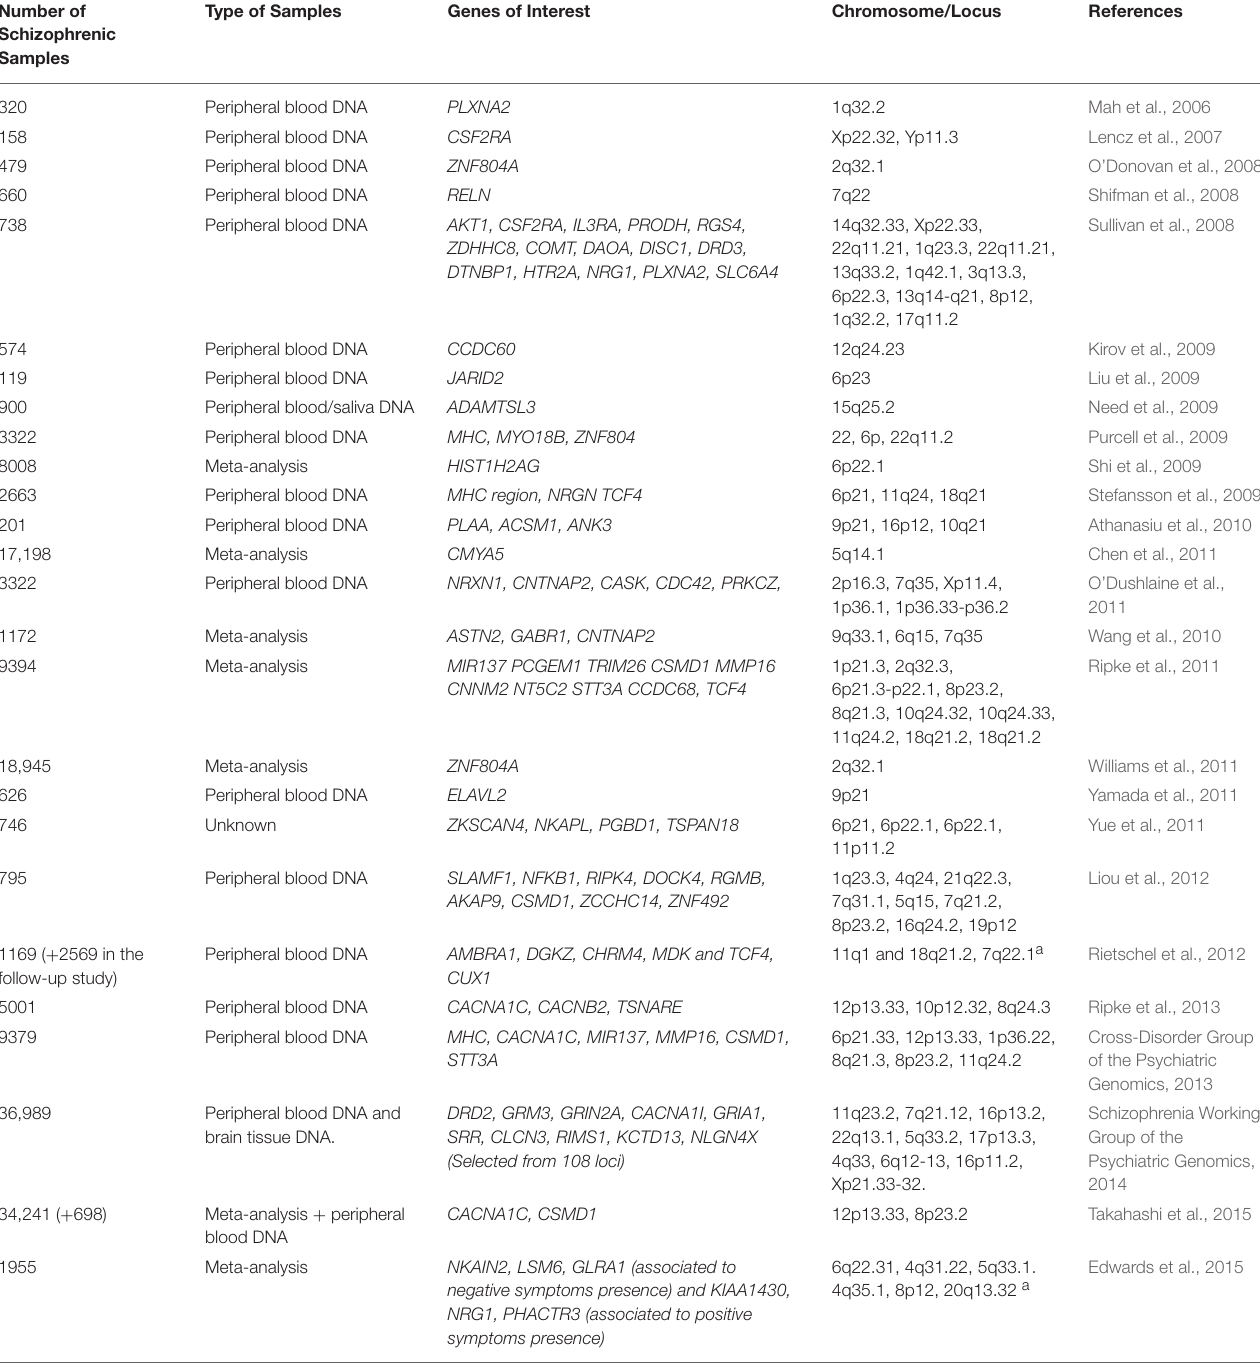
TABLE 1 | Summary of the most relevant findings in GWAS studies in schizophrenia. Number of